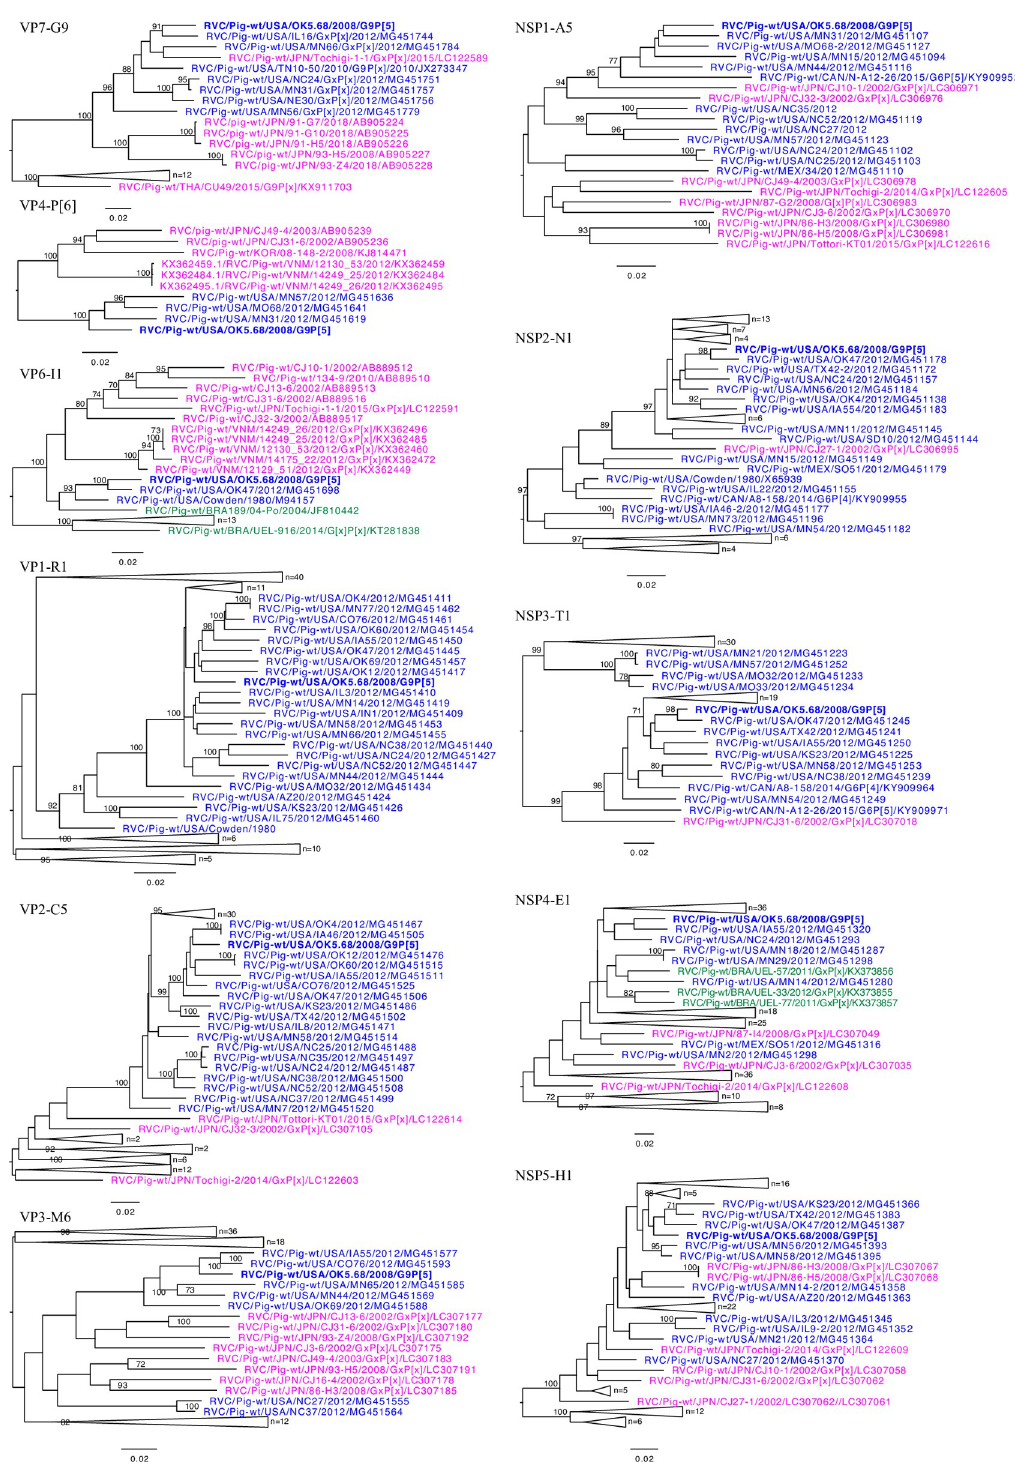
Fig 2. Phylogenetic trees of the RVC strain OK5.68. The RVC strain from this study is represented in bold. The strains from Asia, North America, and South America are colored pink, blue, and green, respectively.